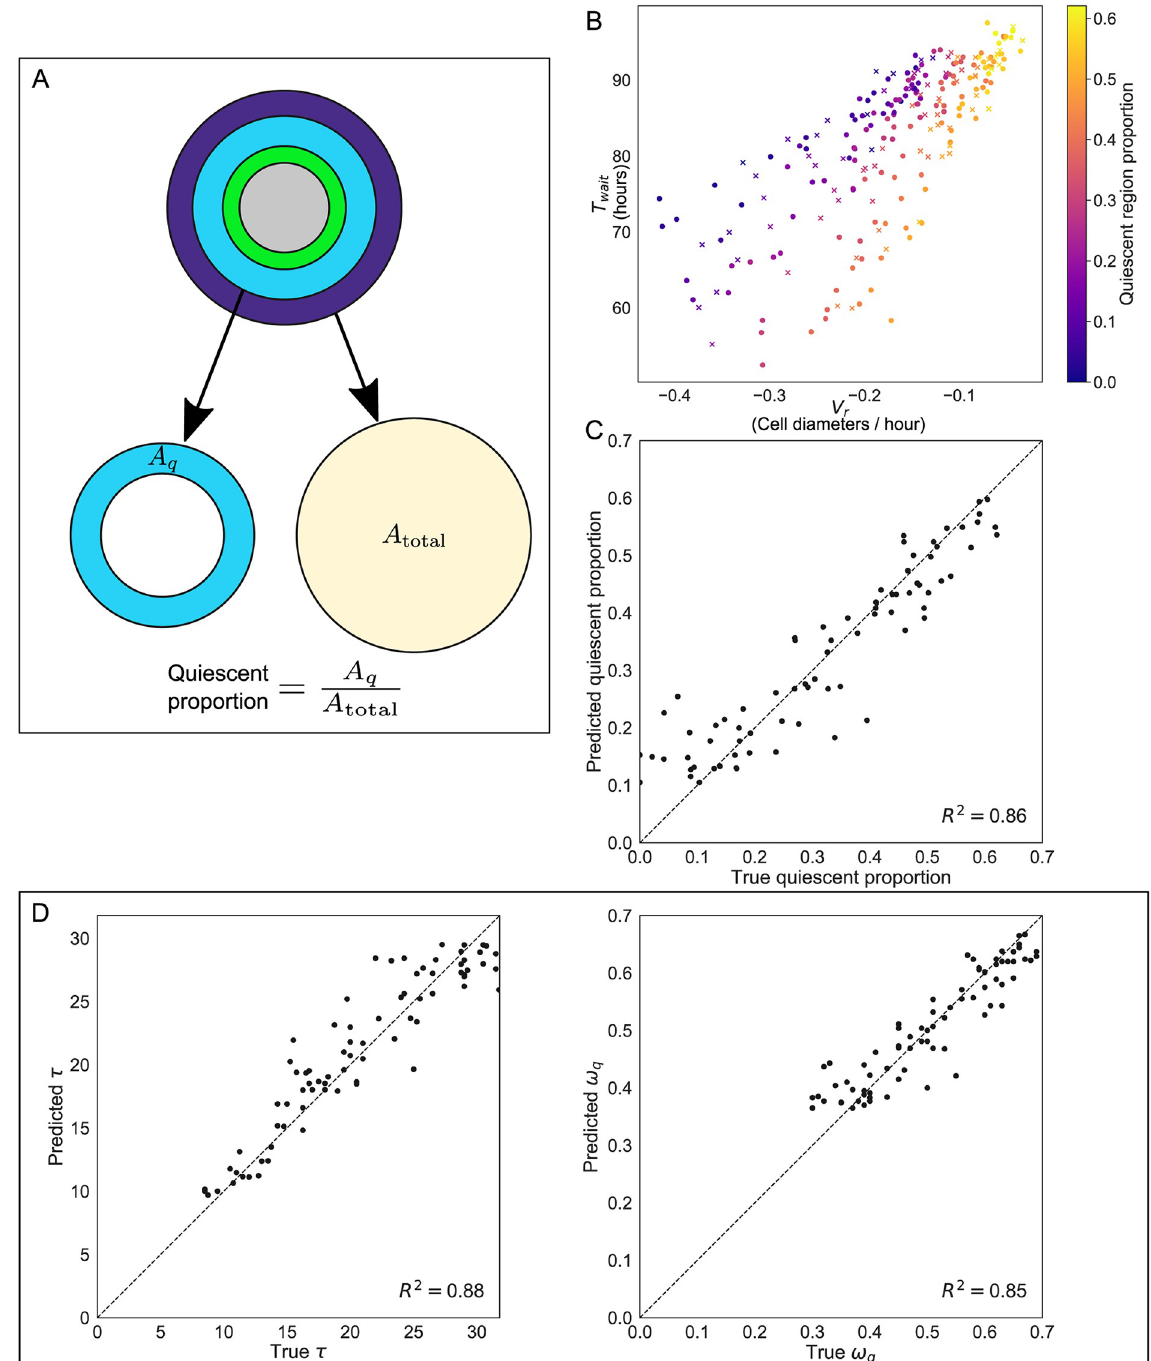
Fig 6. Observations of T wait and V r can be used to predict spheroid composition and simulation parameters. A: Schematic showing how the composition of the spheroid was defined in order to make predictions. The proportion of the spheroid which was quiescent is defined as the area of the quiescent region, A q , divided by the total spheroid area A total . (Comparable results are obtained when defining the quiescent proportion of the spheroid as the width of the quiescent annulus divided by the total spheroid radius.) B: Proportion of the spheroid radius accounted for by the quiescent compartment for simulations with randomly selected ω q and τ (with fixed ω h = 0.3 and ~ t ¼ 8 ). Approximately two-thirds of the simulations (100 out of 148, marked as circles) were used to train a k -nearest neighbours classifier to predict the composition of spheroids in the remaining simulations (48 out of 148, marked as crosses). C: Results of using 10-nearest neighbours classification to predict the proportion of each tumour spheroid which was quiescent based on observed values of T wait and V r for microbeads in each simulation. D: